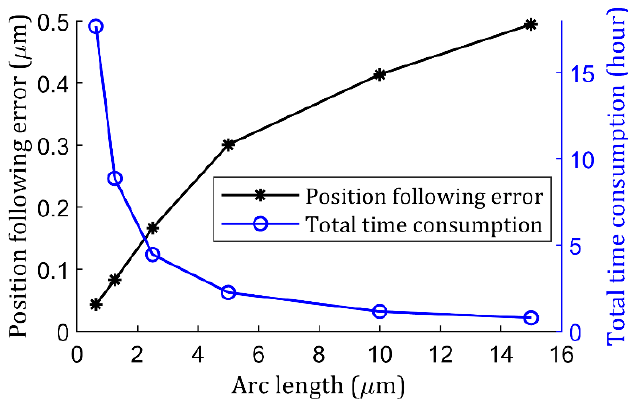
Figure 7. Position following error and total time consumption verse arc-length study.